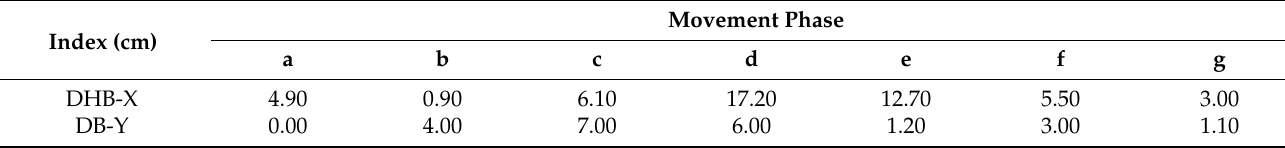
Table 2. Technical stability of the snatch (DHB-X is the distance between the center of gravity of the human body and the barbell on the sagittal plane, DB-Y is the distance between the center of gravity of the human body and the barbell center on the coronal plane).